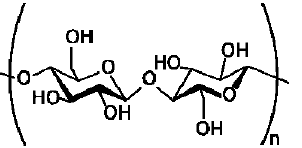
Figure 1. Chemical structure of cellulose. Cellulose is composed of β -1-4-linked D -glucopyranose